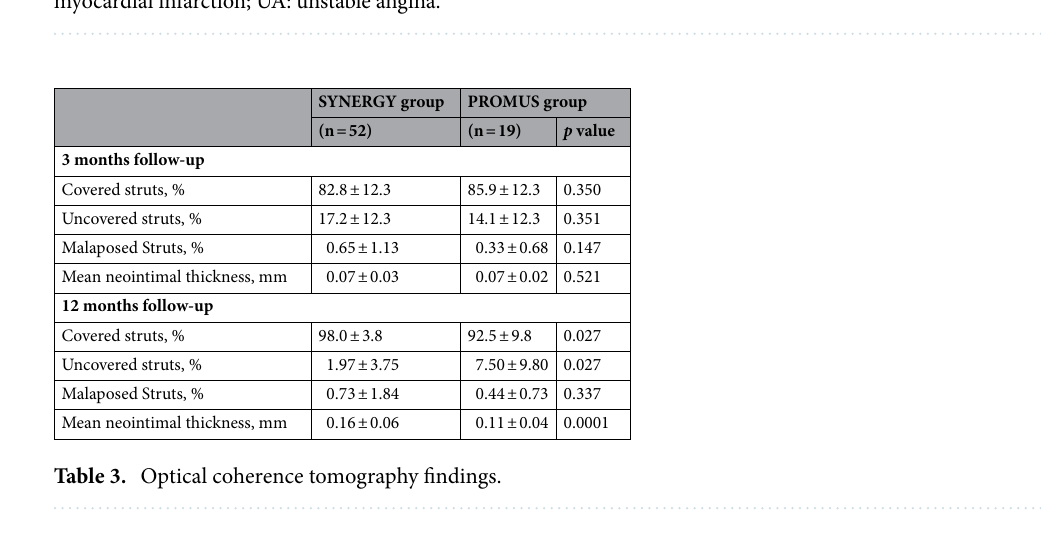
Figure 3. Comparison of serial changes in circulating progenitor cells between patients with ST-elevation myocardial infarction and those with non ST-elevation myocardial infarction or unstable angina in the limited patients of the SYNERGY group. STEMI: ST-elevation myocardial infarction; NSTEMI; non ST-elevation myocardial infarction; UA: unstable angina.